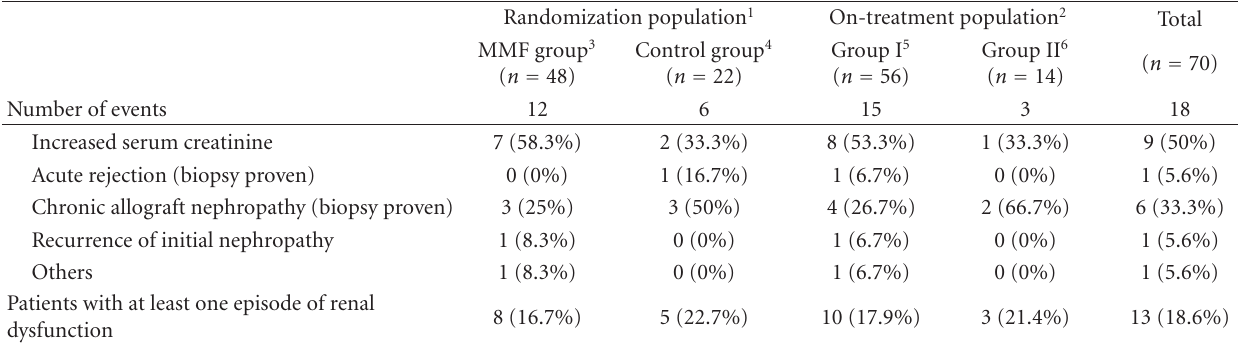
Table 3: Renal dysfunction. Randomization population 1